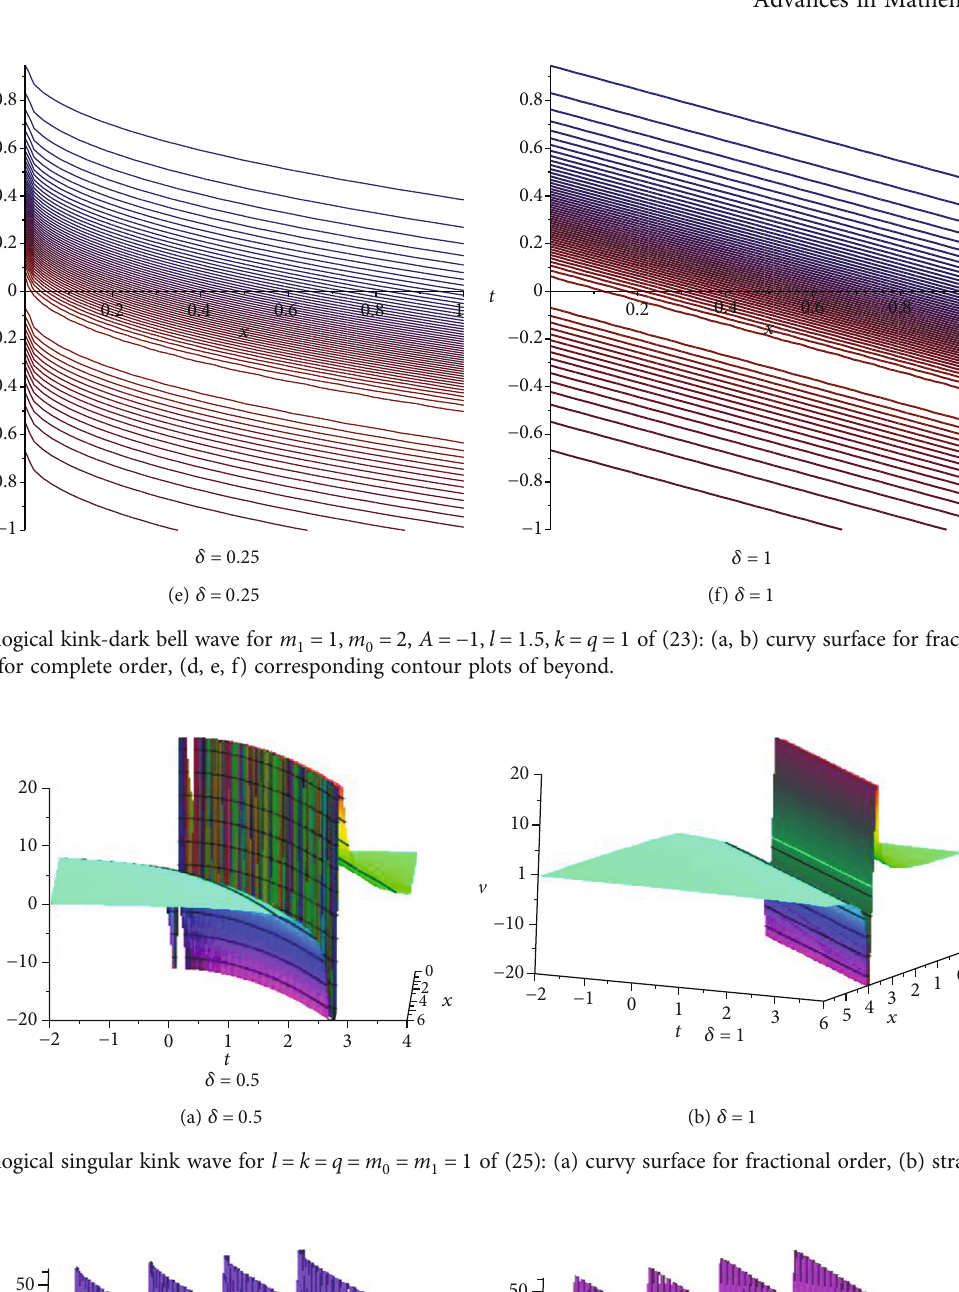
= m = 1 of (25): (a) curvy surface for fractional order, (b) straight surface for 0 1